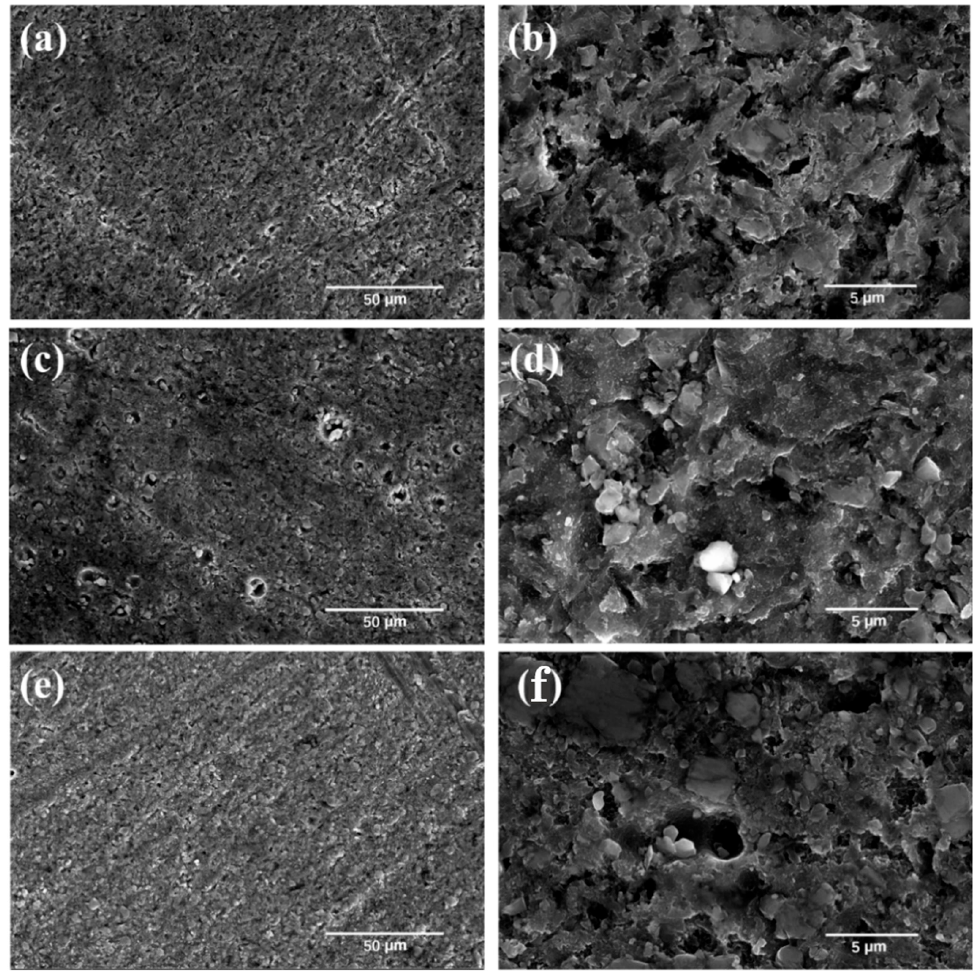
Figure 6. SEM images of the corrosion surfaces of Al-7%Si-0.3%Mg-0.3%Cr alloy aged at 175 °C for ( a , b ) 1 h, ( c , d ) 6 h, ( e , f ) 12 h after immersion for